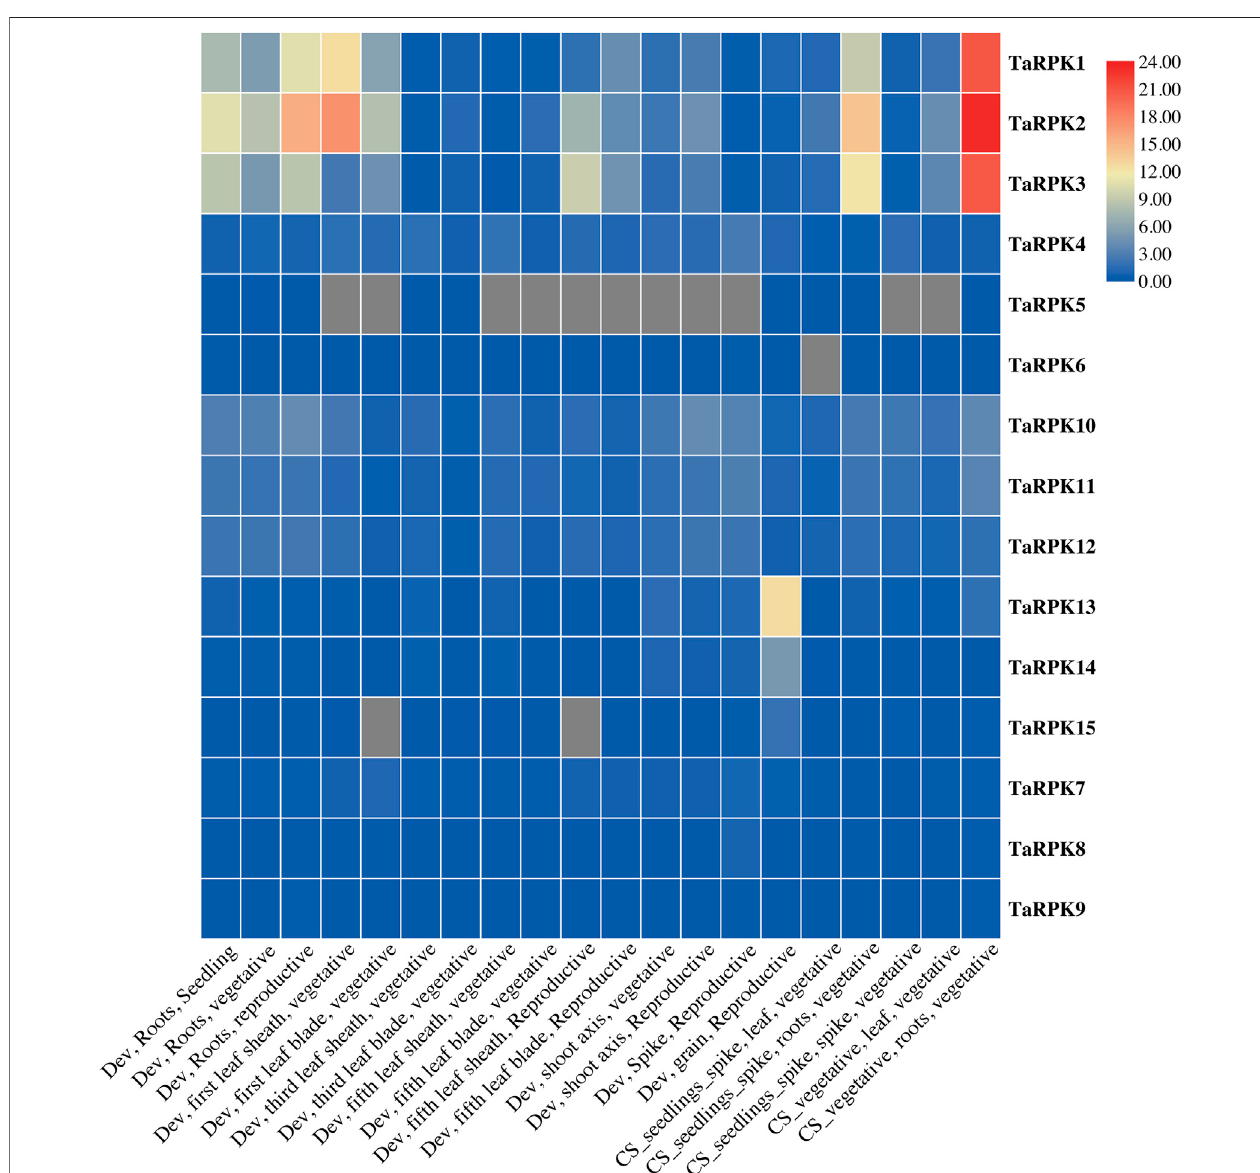
FIGURE8| Insilico analysisof RPK membersindifferenttissues(root,shoot,leaf,grain,andspike)wasgeneratedusingTBtool.Dev=developmentalstage,CS= seedlings spike; Chinese Spring seedlings (leaves, roots) and spikes at anthesis and CS vegetative; Chinese Spring leaves and roots from seven leaf stages. The heatmap was constructed from transcripts per 10 million values with the scale bar displaying expression of the genes. The blue and red colors denote lower and higher expressions of the transcripts, respectively.